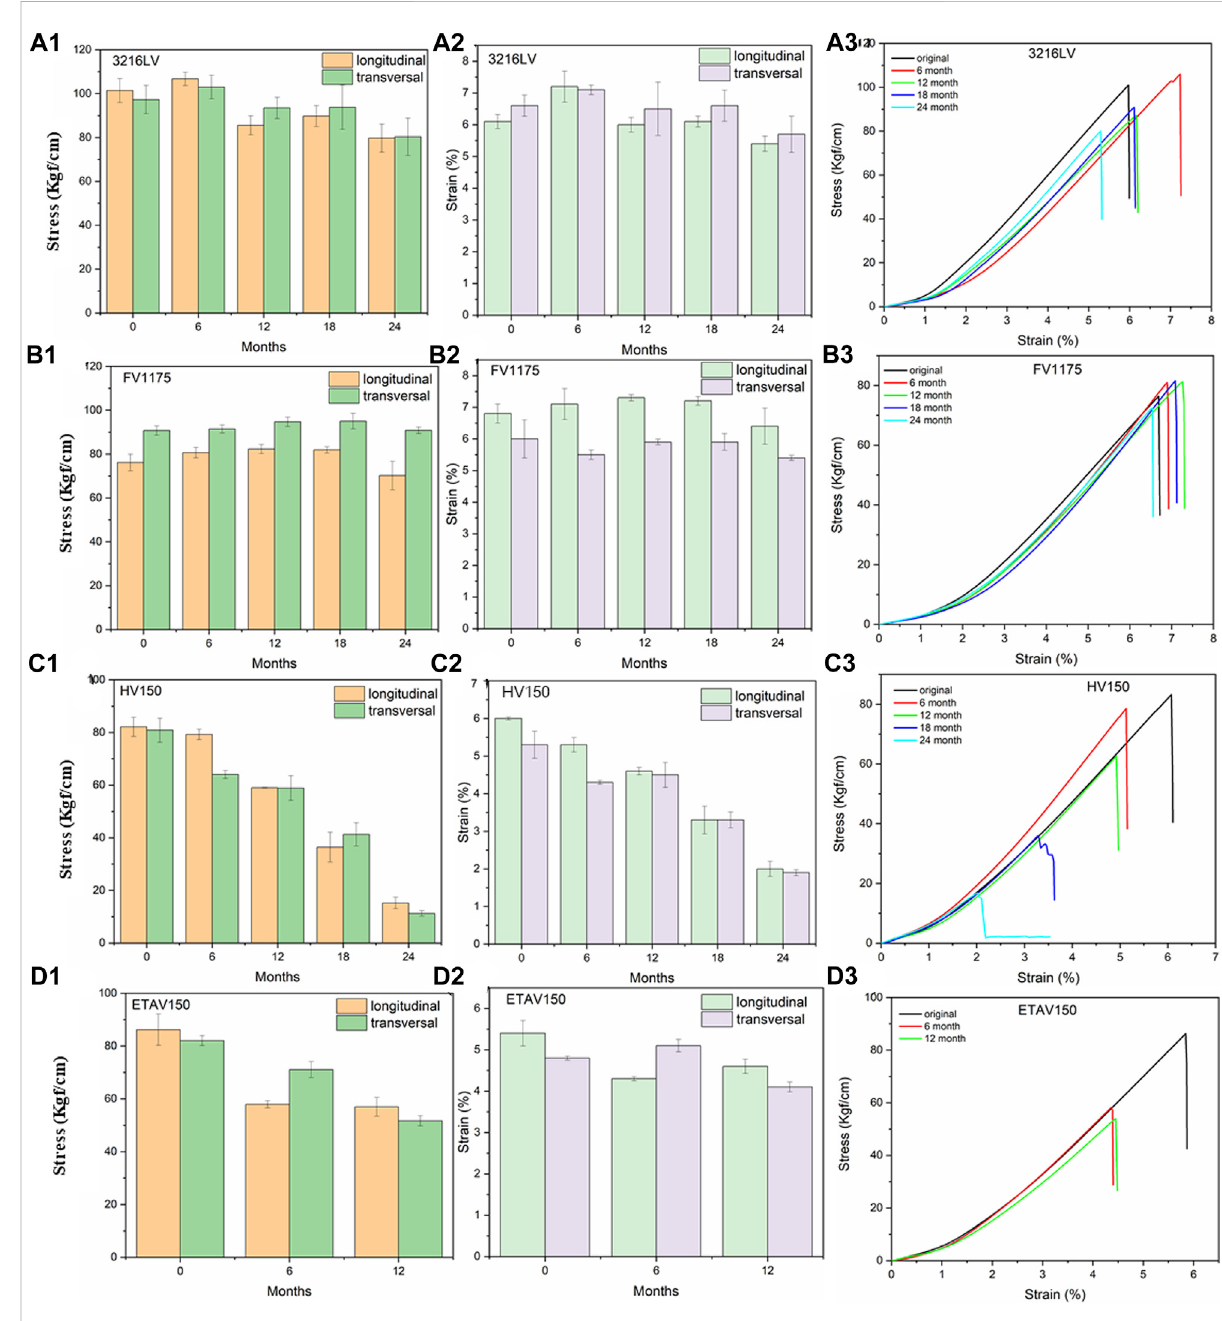
FIGURE 10 Stress-strain curves, bar charts of stress, strain at break and stress-strain curves for (A1-A4) 3216LV, (B1-B4) FV1175, (C1-C4) HV150, and (D1- D4)